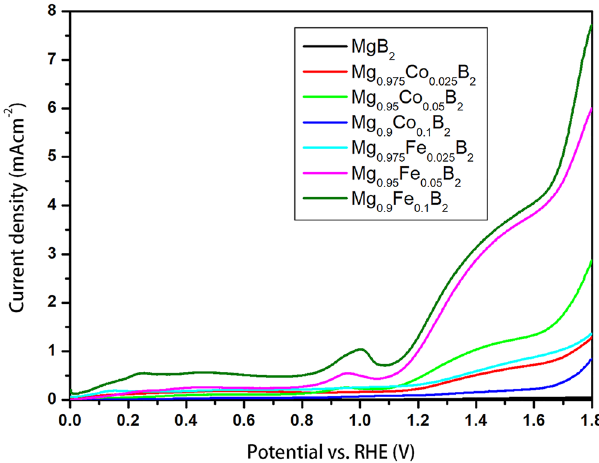
Figure 6. Polarization curves of the OER reaction of pure and doped MgB 2 .